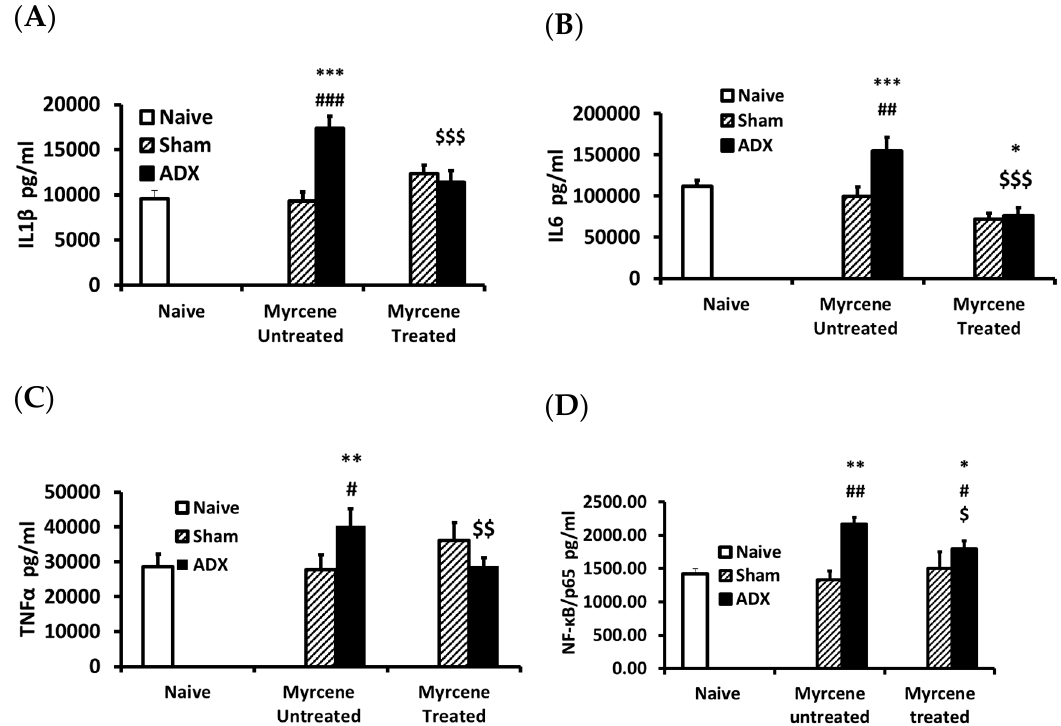
Figure 1. Pro-inflammatory cytokines levels in kidneys of ADX, sham operated, and myrcene treated sham and ADX rats: IL-1 β ( A ); IL-6 ( B ); TNF- α ( C ); and NF- қ B ( D ). The ADX group showed significantly increased concentrations of IL-1 β , IL-6, TNF α , and NF- қ B compared to sham operated group. Myrcene decreased significantly IL-1 β , IL-6, TNF- α , and NF- қ B compared to untreated ADX, while sham controls (untreated and treated) remained unchanged. Each data-point represents the mean ± STD of 6–9 rats per group. * p < 0.05, ** p < 0.01, *** p < 0.001 compared to naïve; # p < 0.05, ## p < 0.01 ### p < 0.001 compared to untreated sham; $ p < 0.05, $$ p < 0.01, $$$ p < 0.001 compared to untreated ADX.